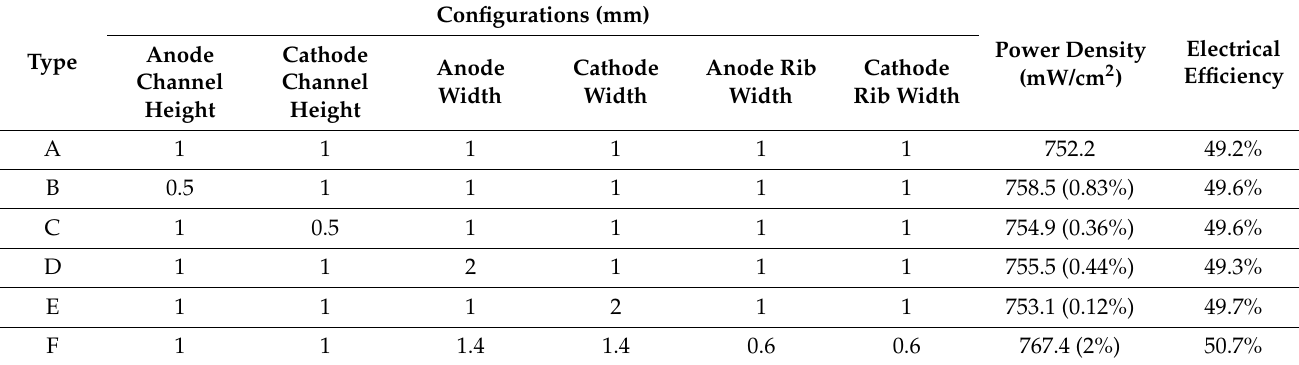
Table 3. Power density for different geometric arrangements of the flow conduits at 0.6 V [98]. Configurations Type